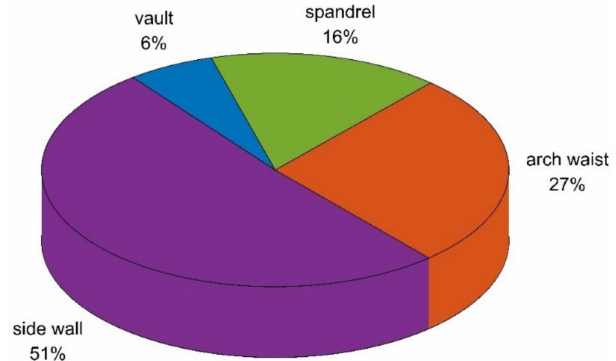
Figure 14. The proportion of each part of the rockburst.